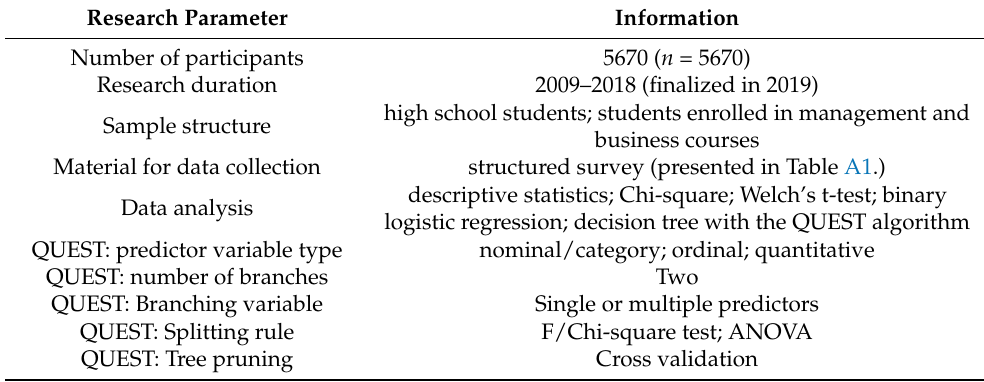
Table 2. Methodology summary and QUEST algorithm information.